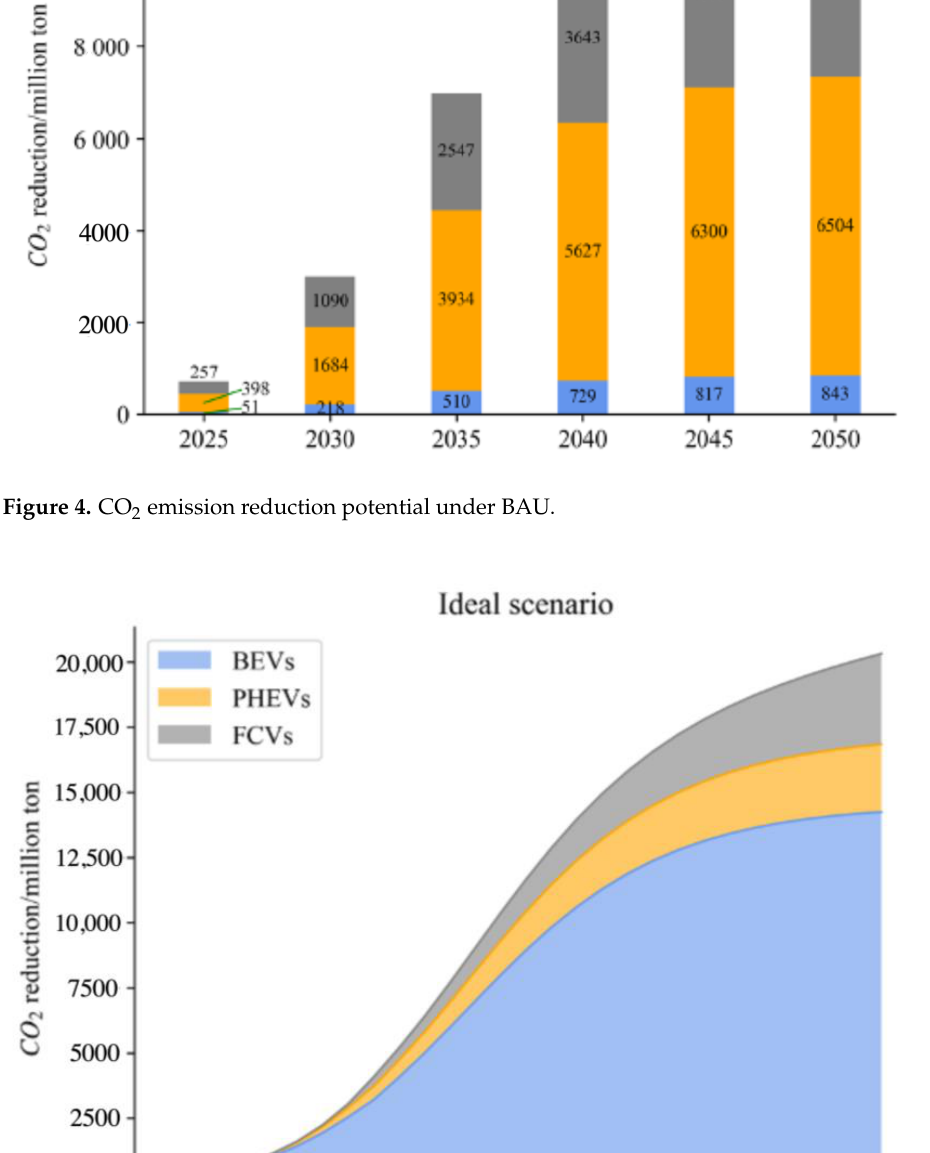
Figure 4. CO 2 emission reduction potential under BAU.